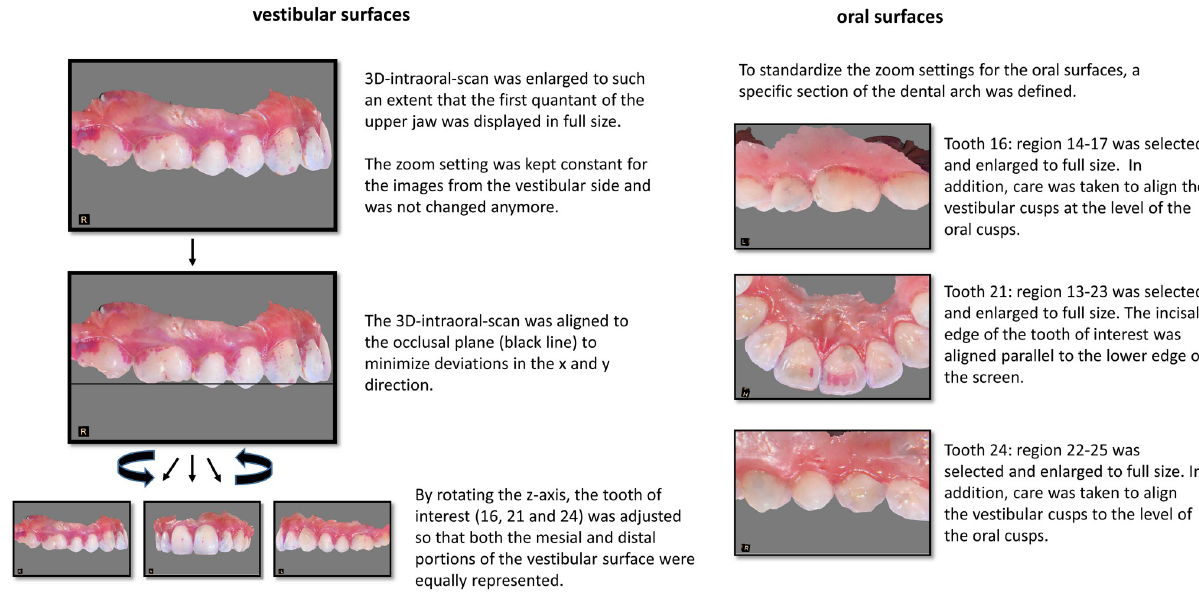
Fig 2. Illustration of scan alignment using the example of an upper jaw; lower jaw scans were processed accordingly.